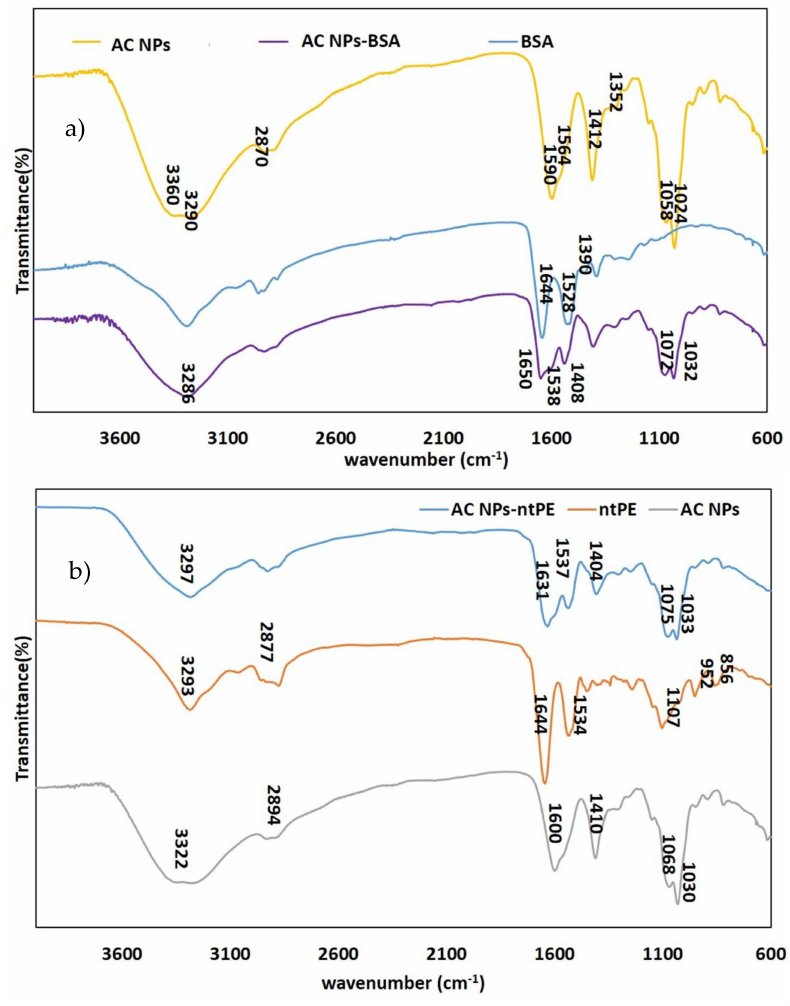
Figure 5. FTIR spectra of NPs. Alginate/chitosan nanoparticles (AC NPs) and bovine serum albumin (BSA) or non-toxic Pseudomonas aeruginosa exotoxin A (ntPE) before and after coupling to AC NPs. ( a ) Spectra obtained for AC NPs, BSA, and AC NPs-BSA. ( b ) Spectra obtained for AC NPs, ntPE, and AC